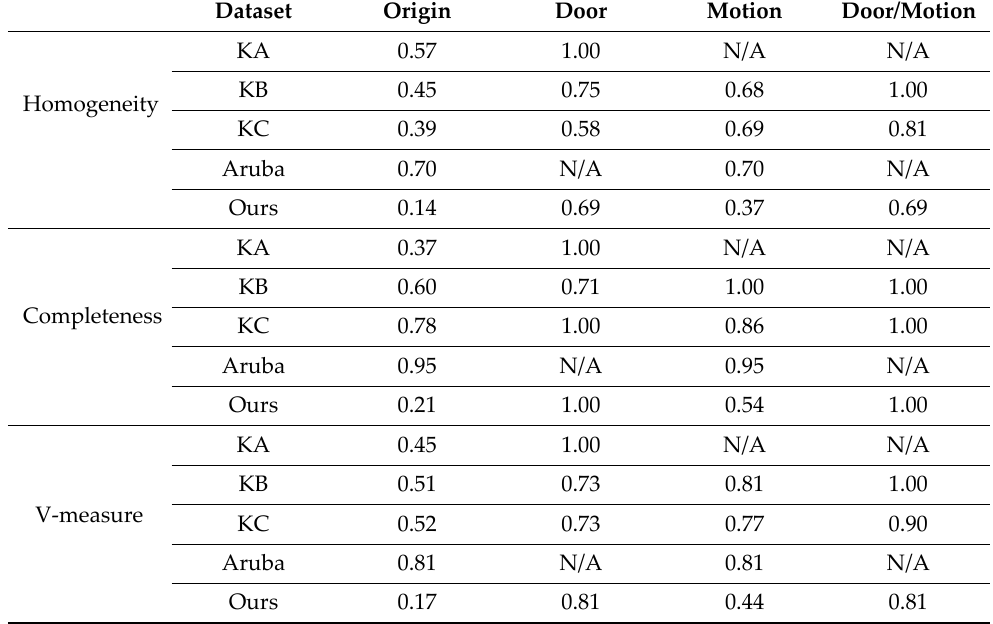
Table 4. Scores of virtual location discovery in each